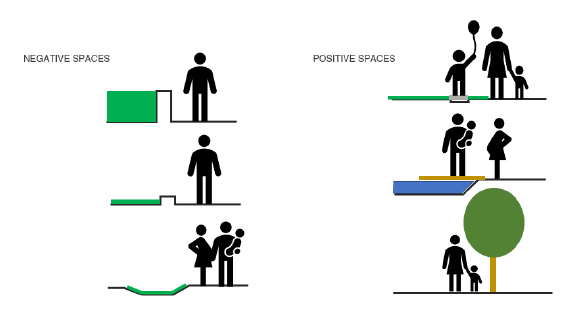
Figure 4. Schematic diagram of the balance between water management and human wellbeing